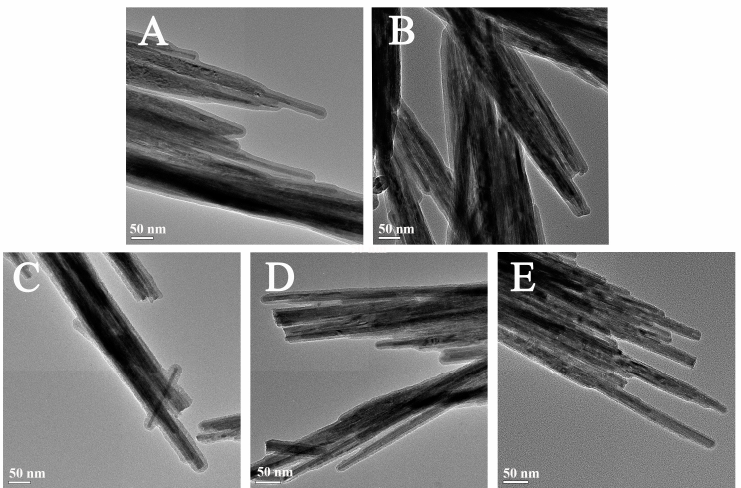
Figure 2. TEM of GdPO 4 ·H 2 O@SiO 2 synthesized with ratios of m GdPO4·H2O :V TEOS (mg/mL) = 4:5 ( A ),